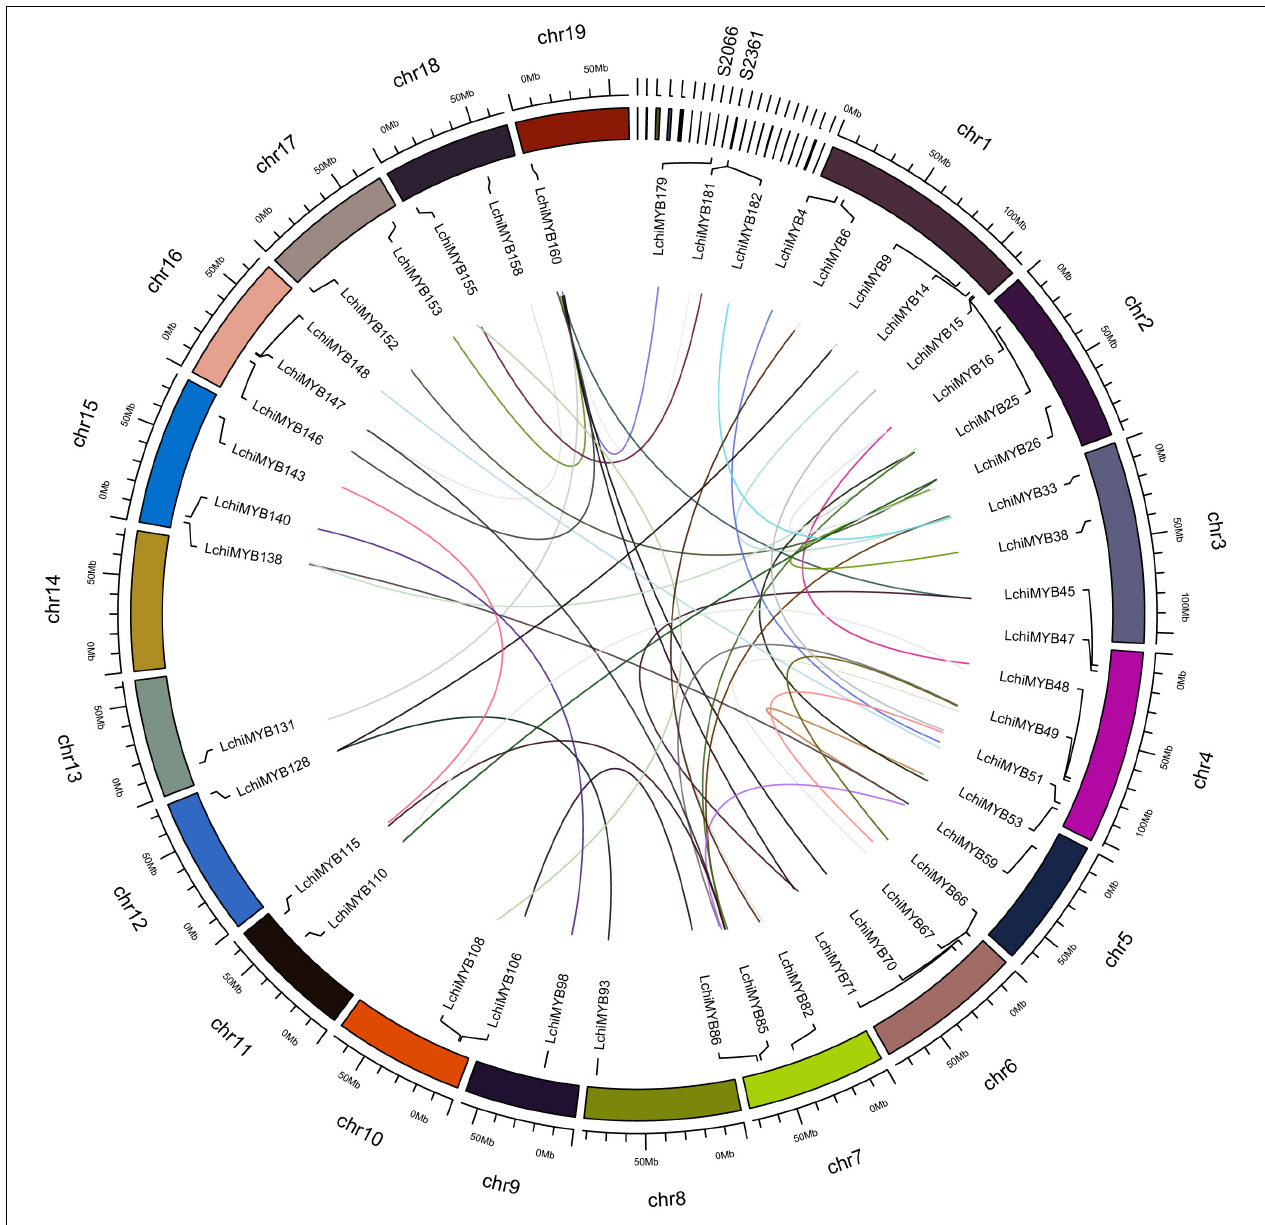
FIGURE 2 | Chromosomal distribution and syntenic relationships of LchiMYBs . The colored curve lines represent duplicated MYB gene pairs. MYB family genes are located on all chromosomes and several scaffolds. Only duplicated gene pairs are shown; all 19 chromosomes are labeled, and only two scaffolds are